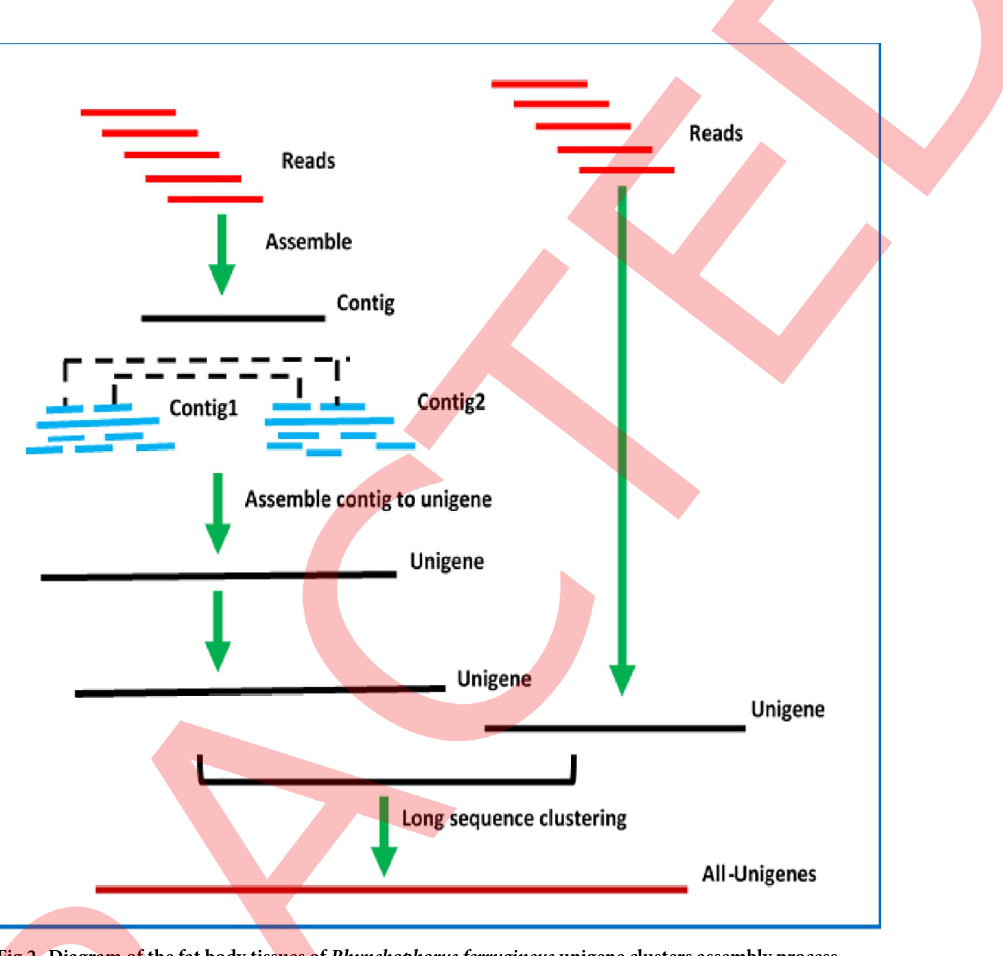
Fig 2. Diagram of the fat body tissues of Rhynchophorus ferrugineus unigene clusters assembly